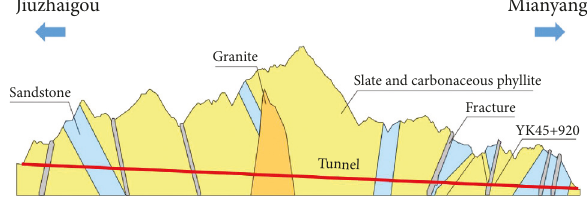
Figure 1: Geological section of the Baima